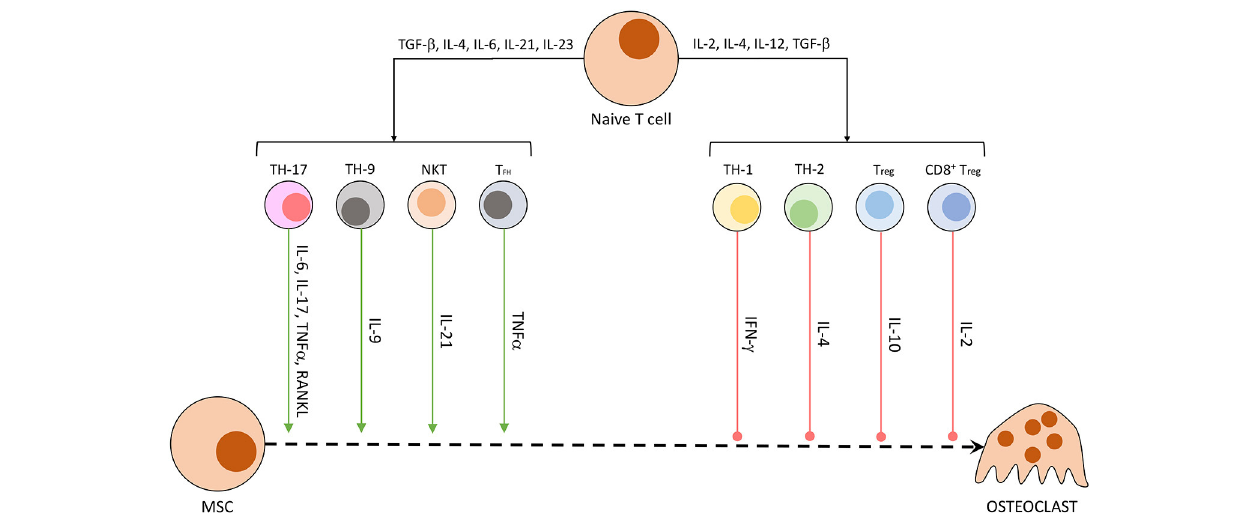
FIGURE 3 | Secreted T cell factors modulating osteoclastogenesis. Naïve T cells undergo differentiation in dependency of exposed factors. A mix of pro-inflammatory and anti-inflammatory conditions leads to the development of differentiated T cell subtypes. These specialized cells then produce a characteristic fingerprint of soluble molecules, which induce or hamper OC development and activity.